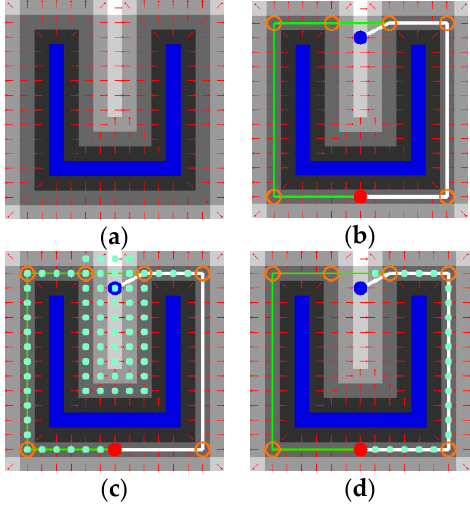
Figure 8. Examples of using LRTA* to search paths, with or without guidance of a high-level path provided by DM-based subgoal graph. ( a ) A DM with safety radius R = 1.5 constructed on a concave blocked region; ( b ) The high-level path connecting the start and the goal cells can be searched from the DM-based subgoal graph; ( c ) The trajectory from the start cell to the goal cell searched by LRTA*, without guidance of the subgoal graph; ( d ) Making use of the subgoal graph, LRTA* visits much fewer cells when heading for the goal cell, and can efficiently deal with dynamical terrain changes which do not destroy connectivity.